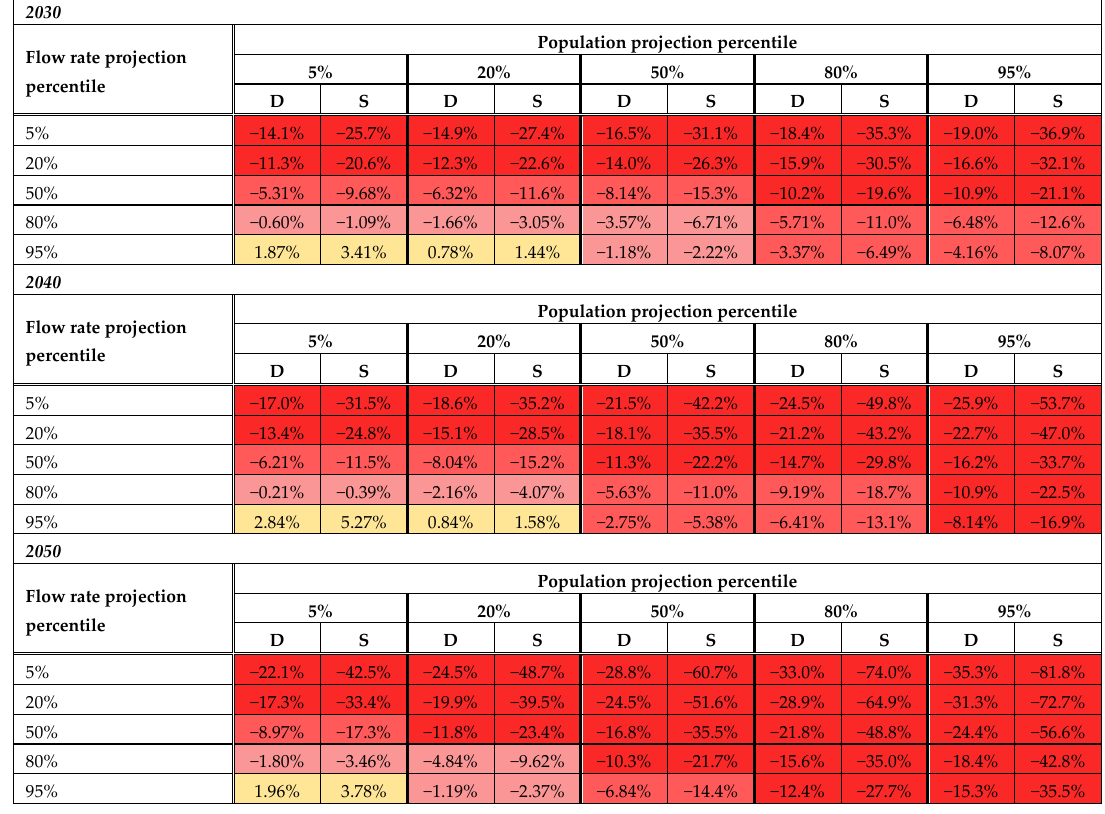
Figure 5. Total annual extra water available as percentage of total demand (D) and storage capacity